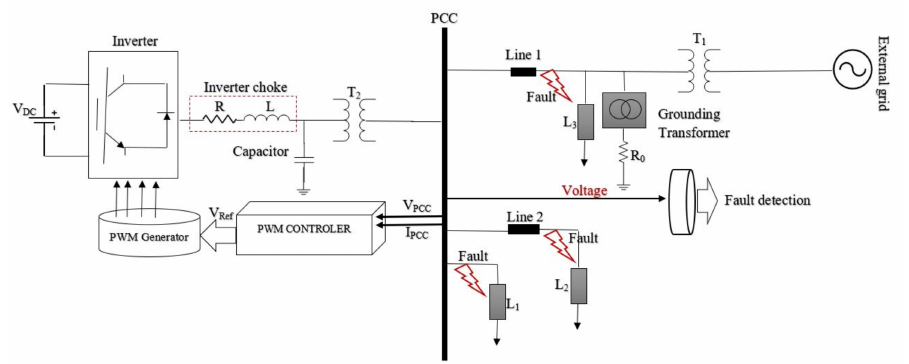
Figure 2. Structure of the studied